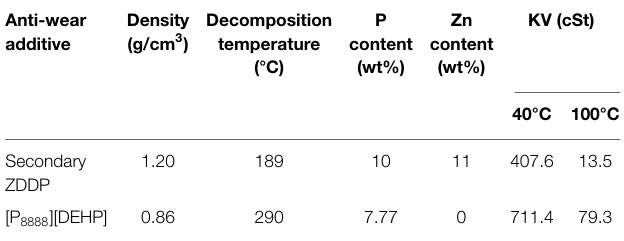
TABLE 1 | Physical and rheological properties of neat anti-wear additives. Decomposition temperature was measured in air . Anti-wear